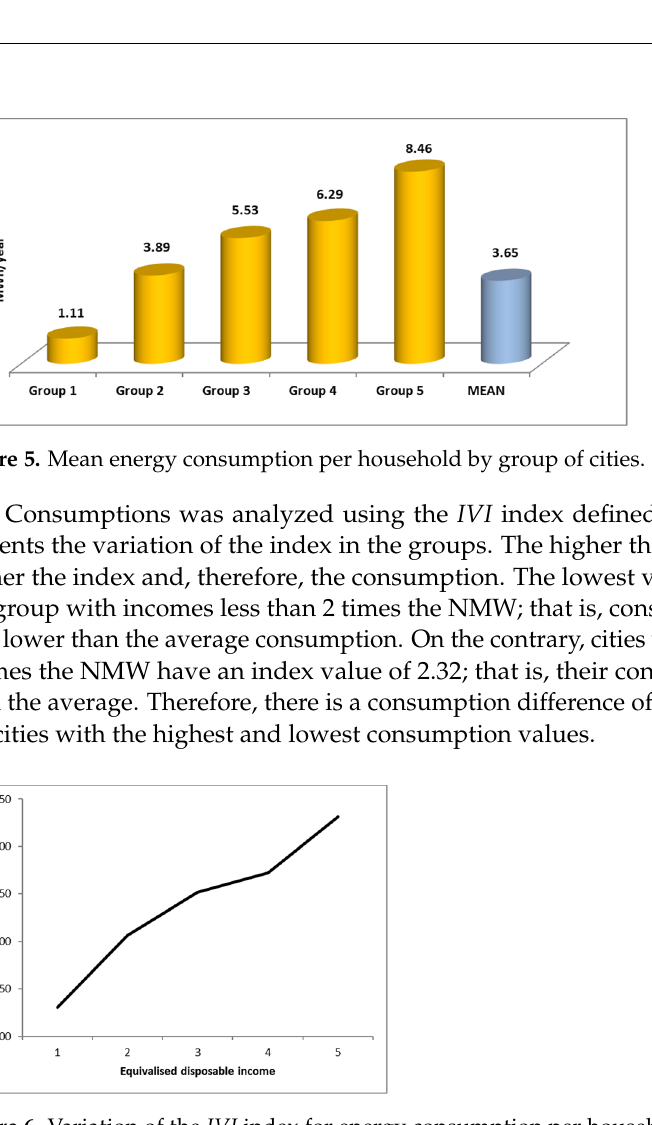
Figure 6. Variation of the IVI index for energy consumption per household by group of cities.